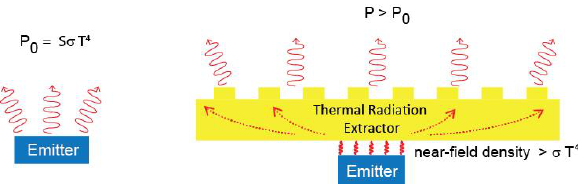
Figure 1: Schematic of radiative cooling. (Left) Emitter without ther- mal extractor. (Right) Radiation power of emitter with thermal ex- tractor is larger than that on the